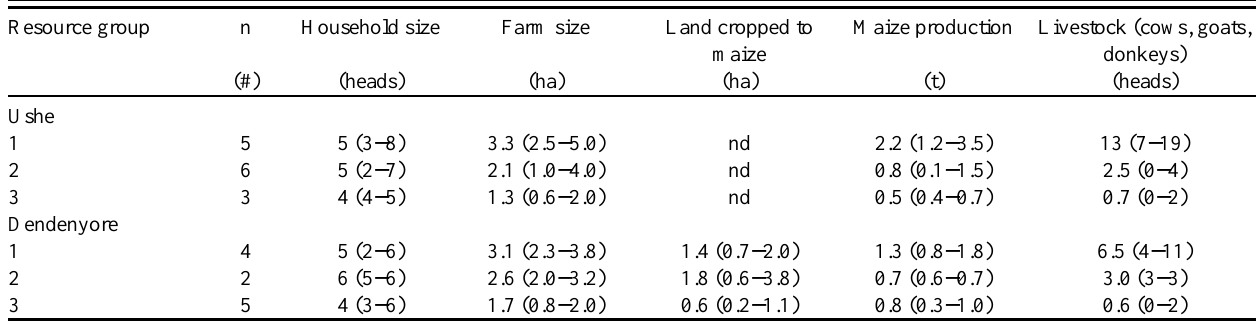
Table 1 . Household characteristics, land owned, land cultivated, and livestock ownership for the two study sites. Numbers in brackets show the range; nd = no data. Resource